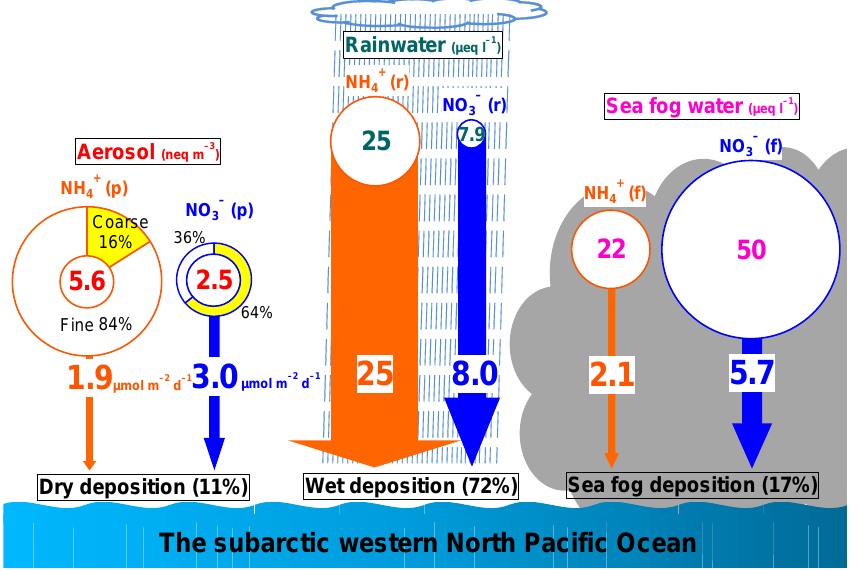
Figure 10. Schematic diagram of atmospheric inorganic N input to the subarctic western North Pacific Ocean during 29 July–19 August 2008. The numbers in circles represent concentrations of NH 4+ and NO 3– in aerosols (in neq m –3 ), rainwater (in µeq l –1 ) and sea fog water (in µeq l –1 ). The mean percentages of total (fine + coarse) aerosol concentrations in fine (D < 2.5 µm, white) and coarse (D > 2.5 µm, yellow) modes for NH 4+ and NO 3– are shown in the circles for aerosol. The orange and blue arrows and numbers (in µmol m –2 d –1 ) indicate NH 4+ (orange) and NO 3– (blue) fluxes via dry, wet, and sea fog deposition.